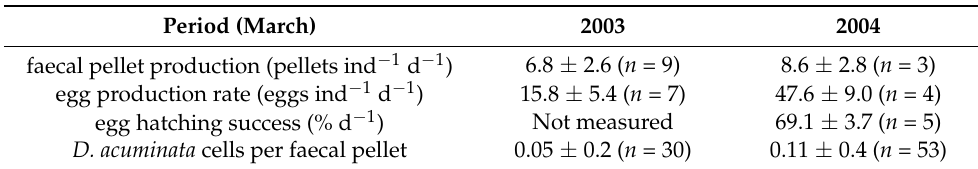
Figure 1. The mean water column copepod abundance (ind m − 3 ) during early March 2003 and March 2004 in Thermaikos Gulf. Table 2. The mean water column values of A. clausi parameters over the sampling period (mean ± SE).